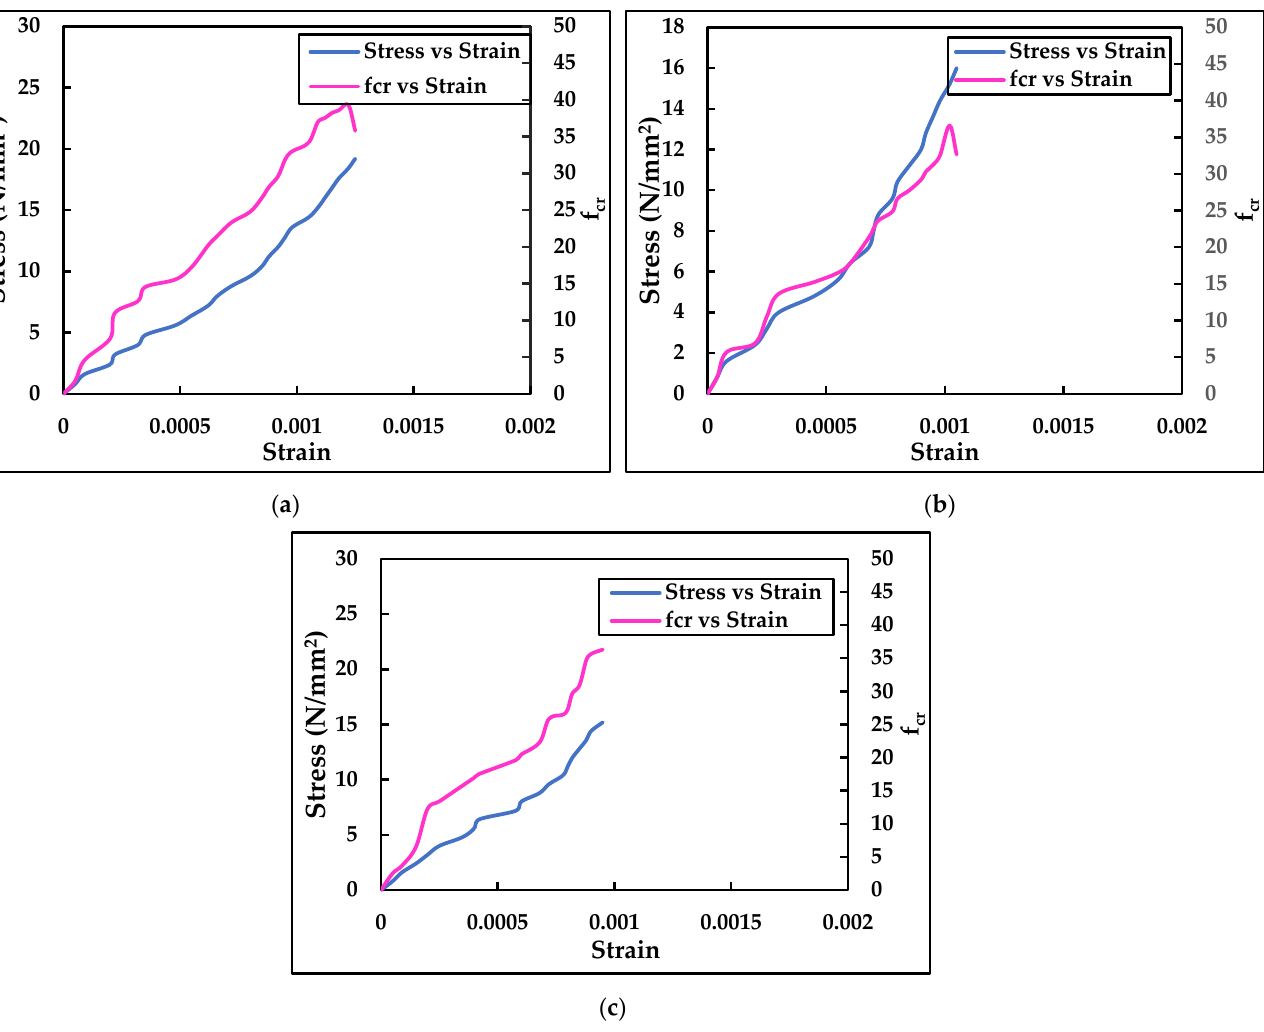
Figure 12. Graphical illustration of stress vs. strain and f cr vs. strain after 28 days of water curing. ( a ) 95% brass fibre with 5% carbon fibre addition; ( b ) 90% brass fibre with 10% carbon fibre addition; ( c ) 85% brass fibre with 15% carbon fibre addition.